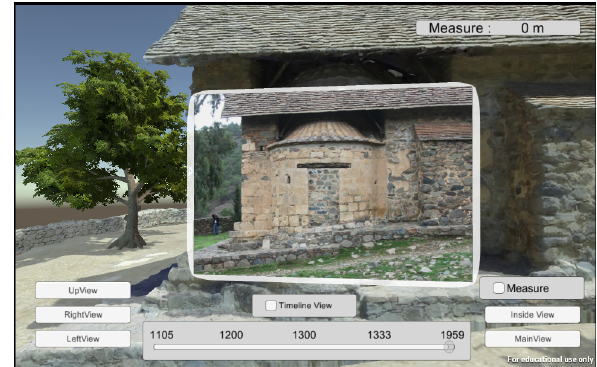
Figure 6: Asinou with Integrated Digital Photographs